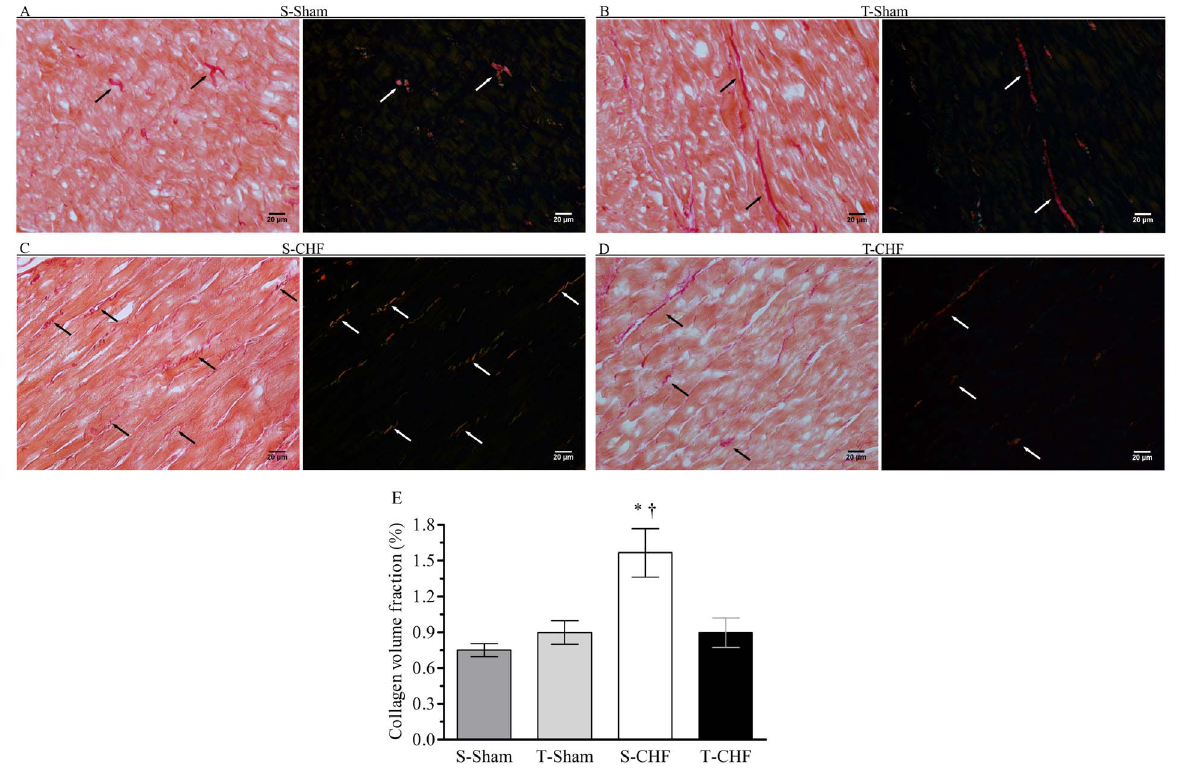
Figure 3. Representative images of ventricular sections stained with Picrosirius (A–D) and statistical analysis (E). Values are means 6 SE. The arrows indicate collagen detected in polarized light. A . S-Sham, sedentary sham rats (n=7); B . T-Sham, training sham rats (n=8); C . S-CHF, sedentary chronic heart failure rats (n=8); D . T-CHF, training chronic heart failure rats (n=8). * P , 0.01 compared to trained groups. { P , 0.001 compared with S-Sham